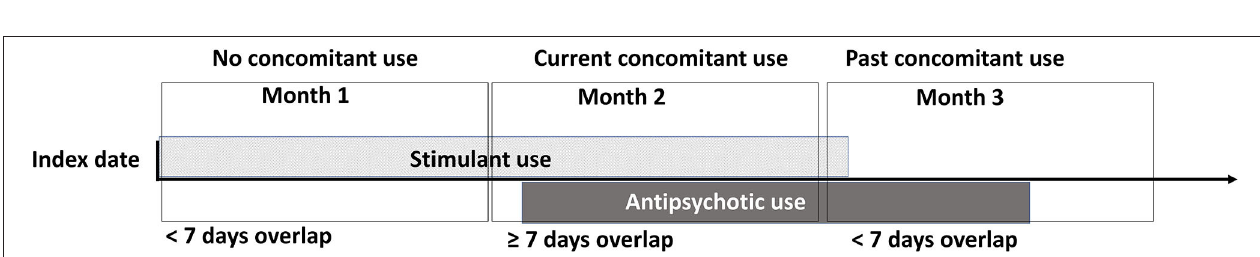
FIGURE 2 | Illustration of time-varying definition of concomitant stimulant/AAP